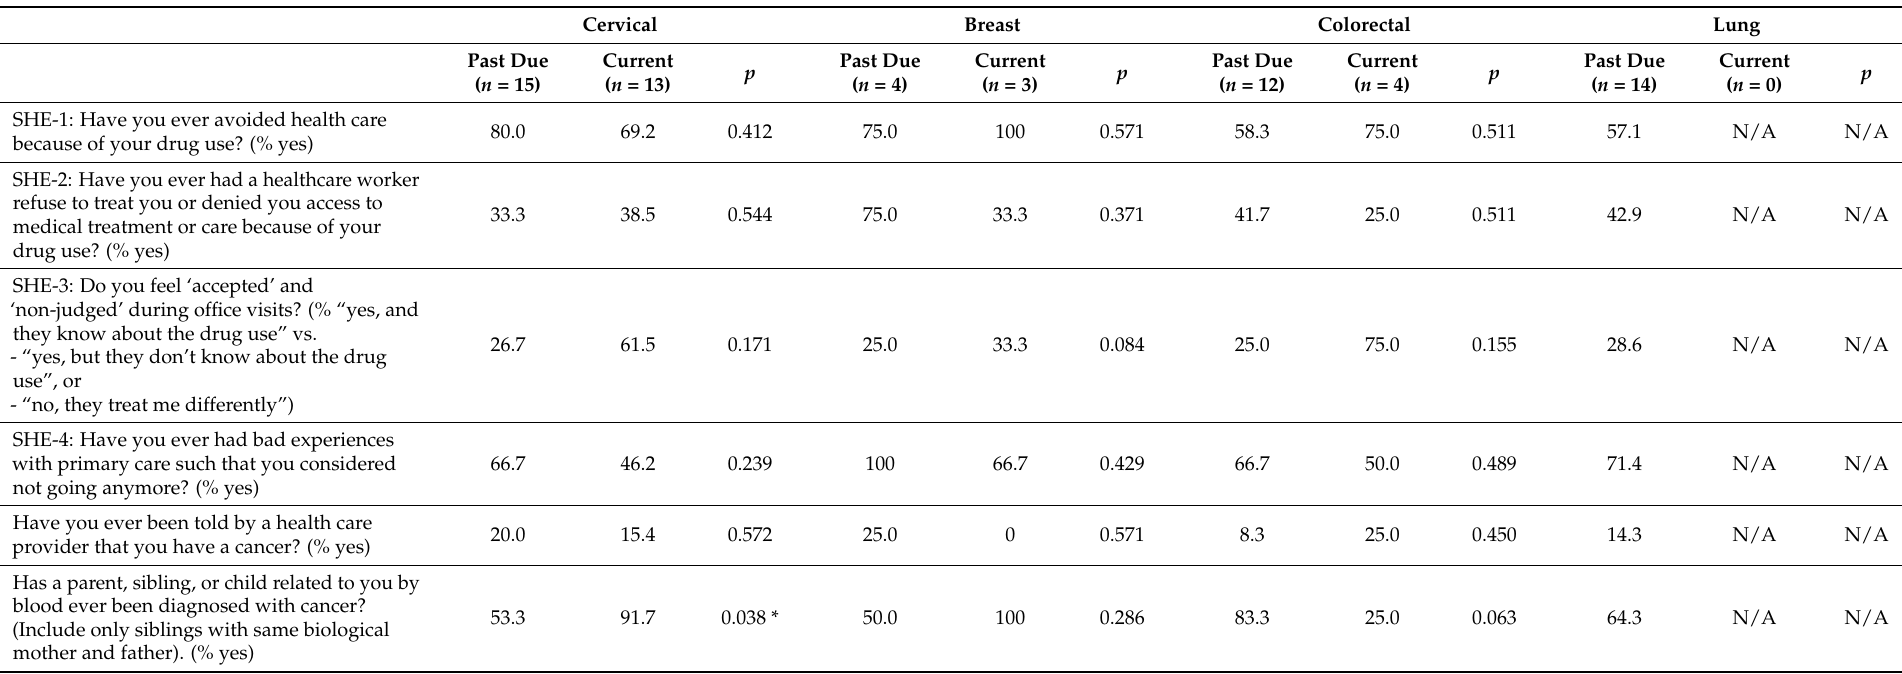
Table 4. Association between healthcare experiences and personal and family cancer history with screening